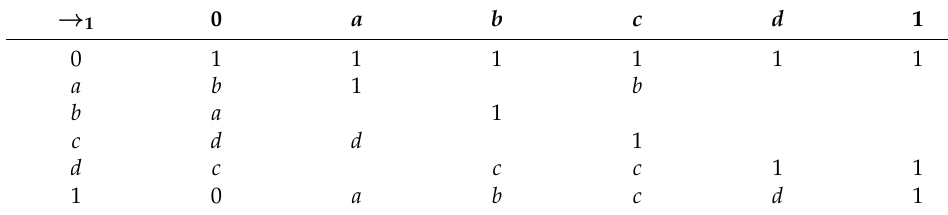
Table 10. The operation → 1 .